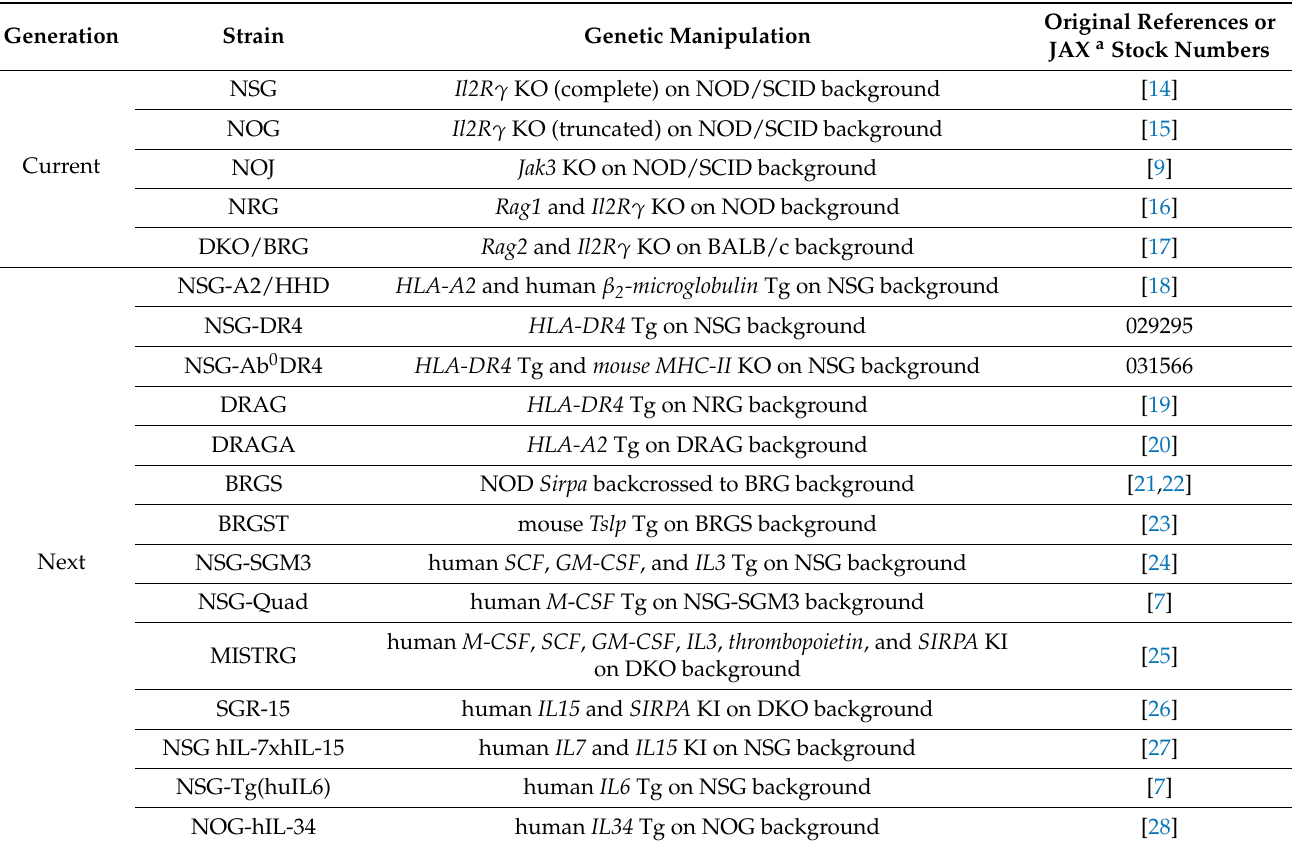
Table 1. Mouse strains for non-BLT humanized mice described in this